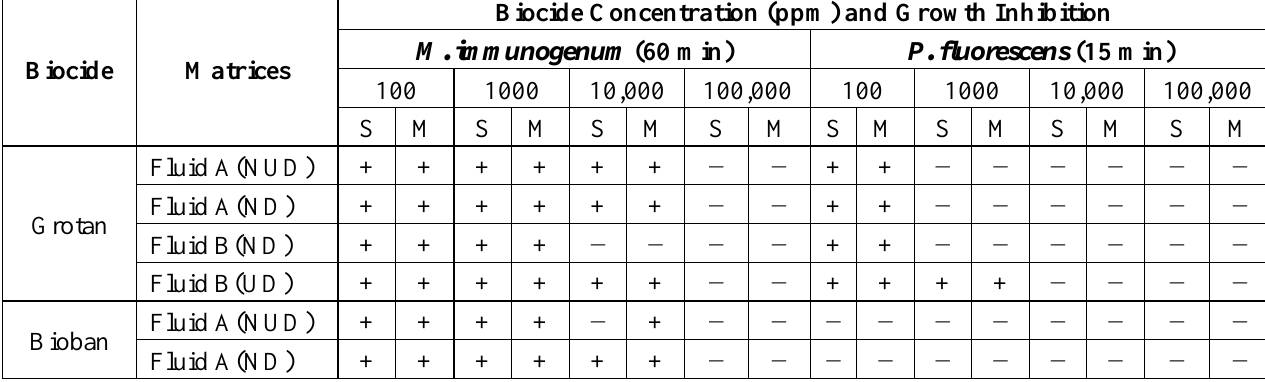
Table 1. MIC estimates for different biocides in MWF based on complete growth inhibition at a particular contact